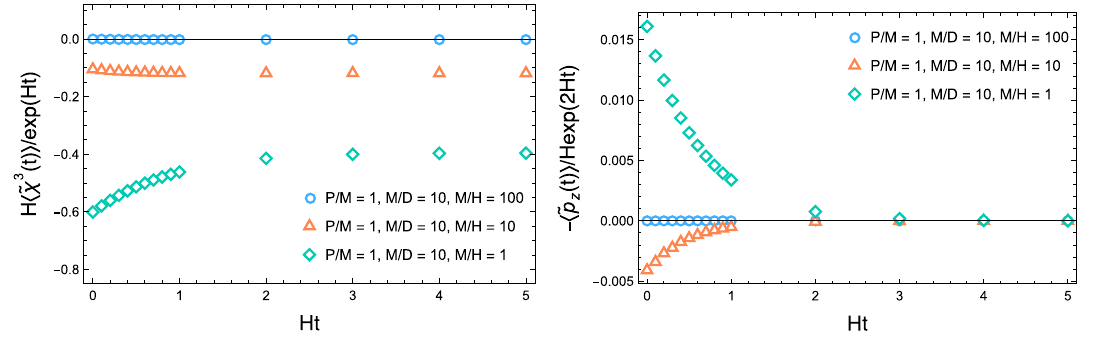
Fig. 4 Left: Numerical calculation of (cid:7) ˜ χ 3 ( t ) (cid:5) . In classical theory, ˜ χ 3 = ˜ z exp ( H ˜ t ) implies ˜ χ 3 = 0 if ˜ z = 0. In quantum theory, this relation holds in the rest frame, i.e. (cid:7) ˜ χ 3 ( ˜ t ) (cid:5) = (cid:7)˜ z ( ˜ t ) (cid:5) exp ( H ˜ t ) , but not, generically, in the non-rest frame. This plot shows that the expectation value of ˜ χ 3 computed in the non-rest frame, (cid:7) ˜ χ 3 ( t ) (cid:5) , is close to zero